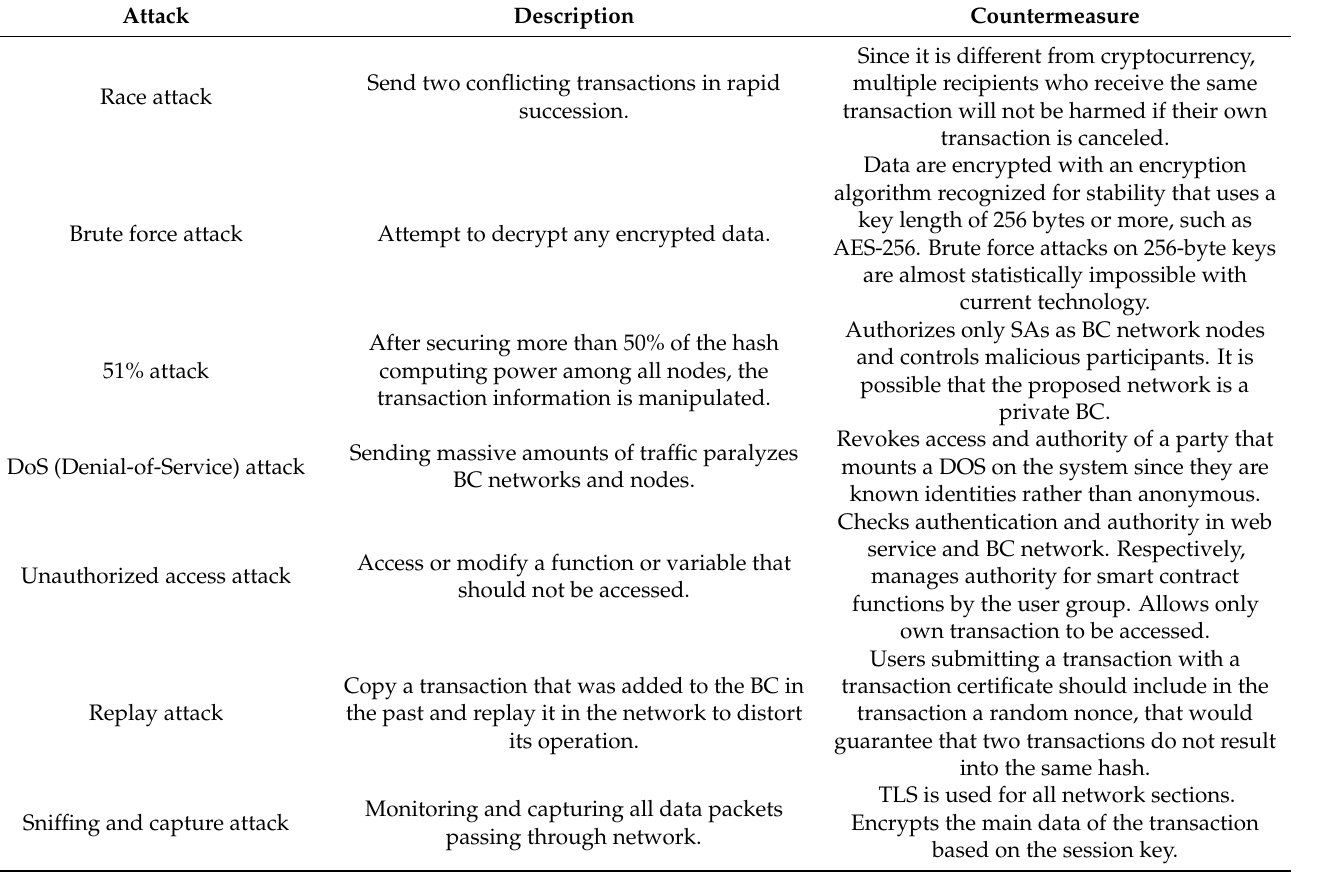
Table 4. Countermeasure to the proposed framework for major cyberattacks on BC.